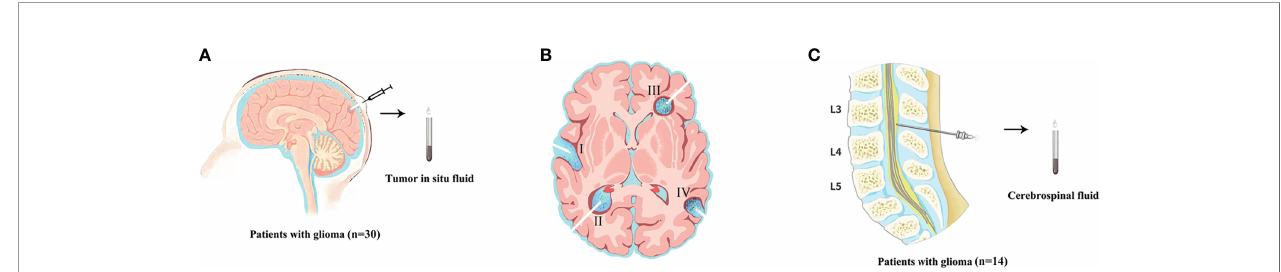
FIGURE 1 | The sample acquisition of tumor DNA. (A) Tumor in situ fl uid samples were obtained. (The state of the tumor at the time of TISF sampling. (B-I/II) TISF- 1: sampled from early progression of residual disease. (B-III/IV) TISF-2: imaging showed tumor progression. TISF-a/TISF-b: Before MRI examination showed a recurrence of the tumor). (C) The sample of cerebrospinal fl uid was